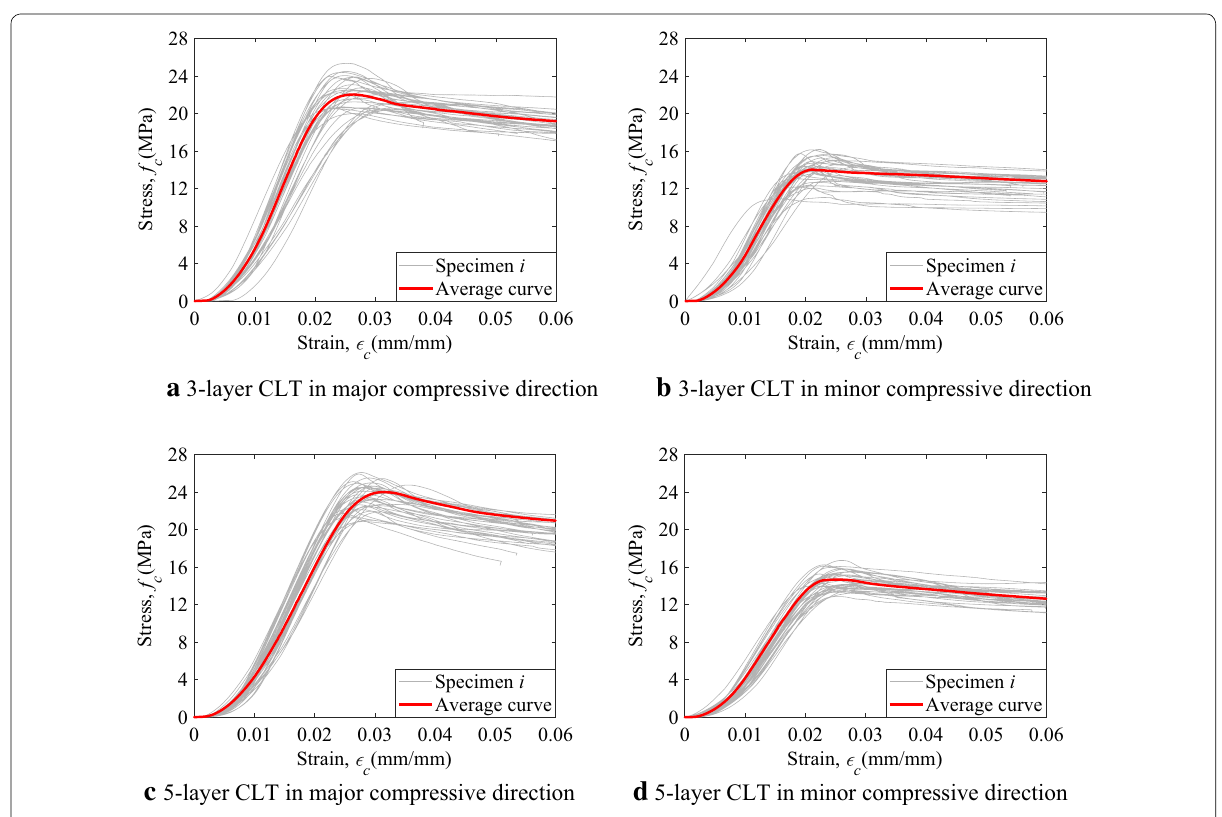
Fig. 5 Stress–strain relationship for CLT panels under in-plane